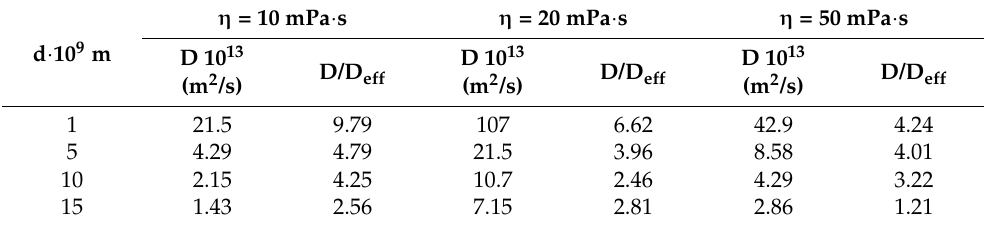
Table 2. Comparison of values of D calculated from Equation (38) with D eff values from Table